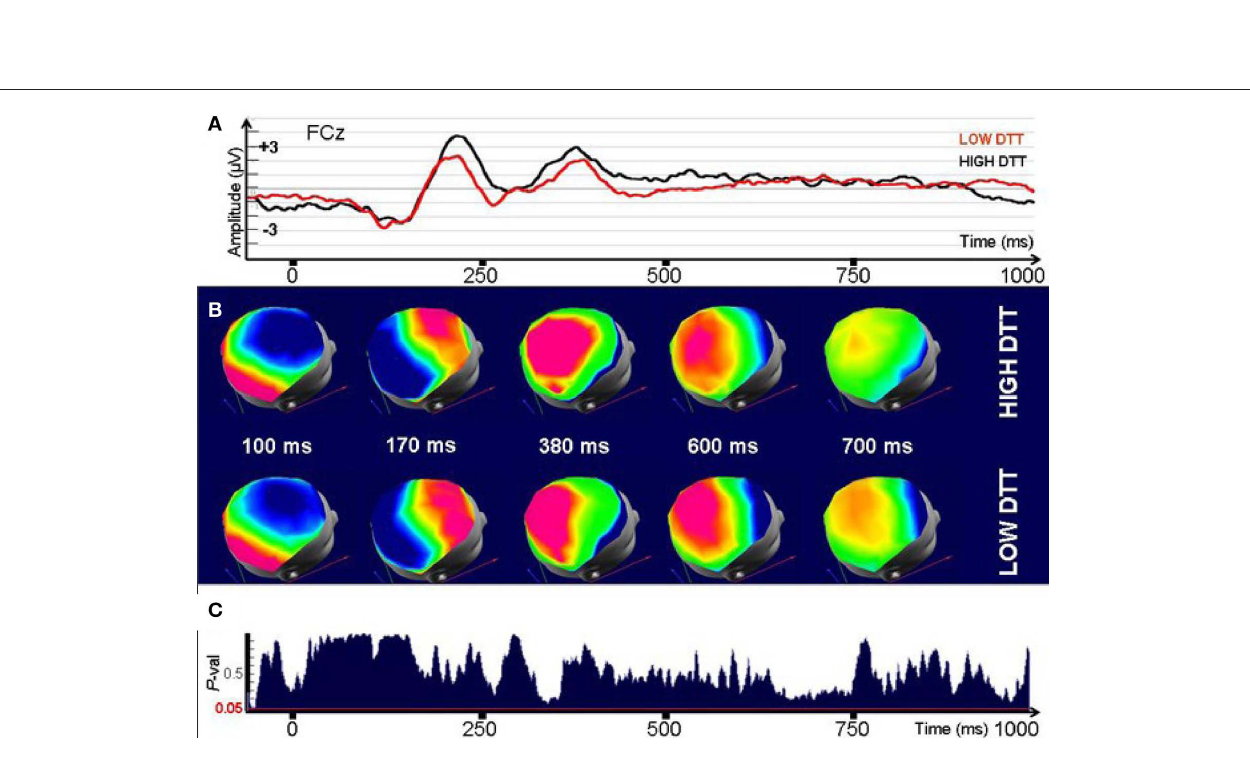
FiGurE A6 | Electrophysiological comparison between High and Low-DTT groups under neutral–positive outcomes. (A) Signals recorded at a fronto-central electrode (FCz) after presentation of the neutral–positive outcomes at time 0. (B) Evolution through time of the corresponding Event-Related Potential maps (C) P -value for a randomized MANOVA performed on the maps. Threshold for significant differences ( P < 0.05) is indicated by the red line. No differences are